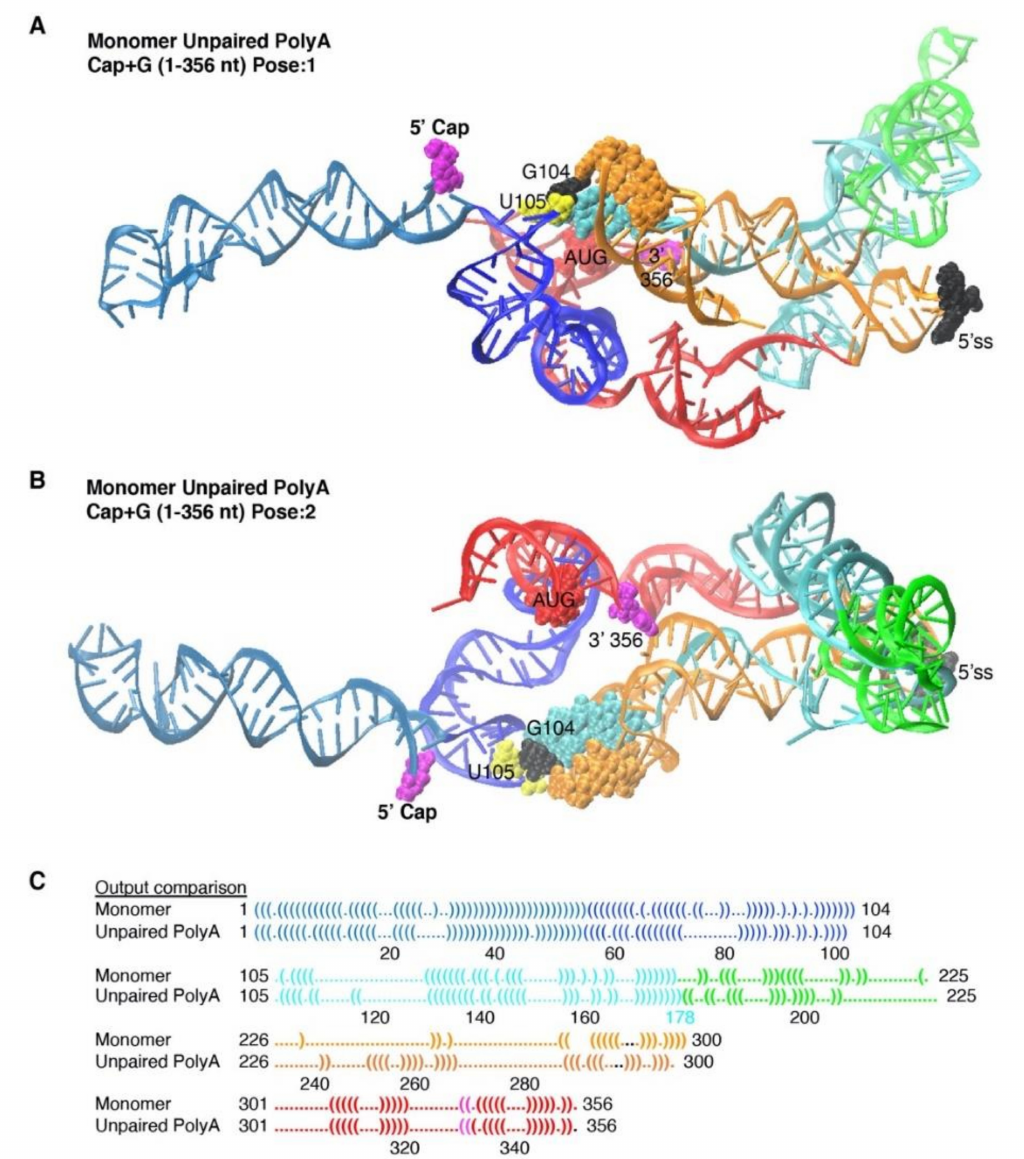
Figure 6. The SimRNA simulation of Monomer is changed by unpairing PolyA. ( B ) Two poses of the most representative SimRNA model of Monomer unpaired PolyA. ( C ) Vienna dot-bracket language comparison of di ff erences between Input and Output constraints. The colored font designates: TAR, light blue; PolyA, navy; U5 stem, cyan; PBS-segment, green; DIS stem, orange; AUG stem, red; 5 (cid:48) -splice site (5 (cid:48) ss), black; nt of the 3-way junction, orange. Space filling atoms: 5 (cid:48) -Cap, white; G104, yellow, U105, black, AUG translation start codon, red ( A , B ) or magenta ( C